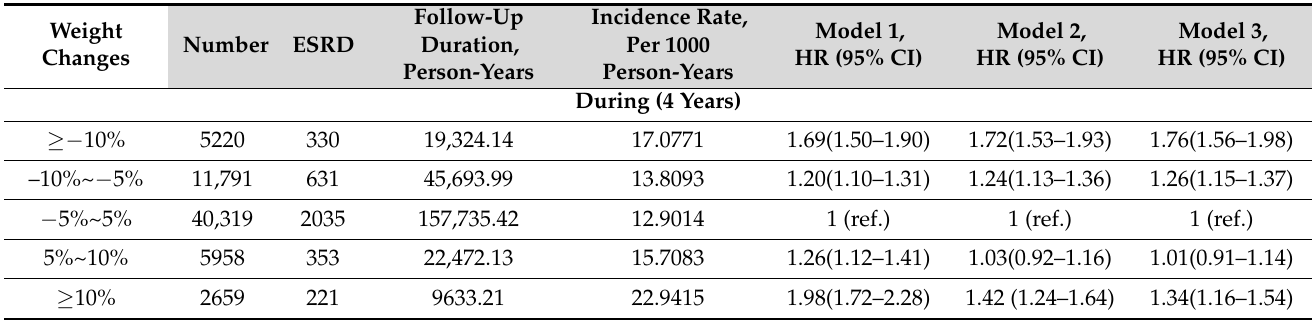
Table 3. Sensitivity analysis of incidence rates and hazard ratios of ESRD according to the weight change status after excluding ESRD with 4 years of follow-up.